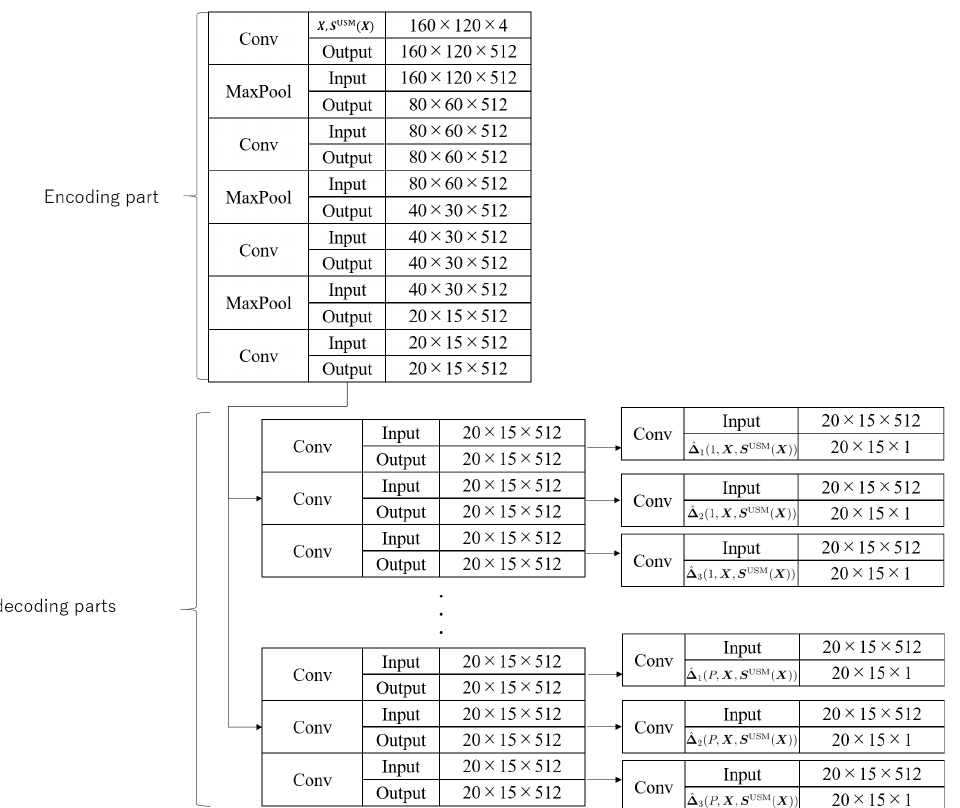
Figure 3. The details of the multi-task CNN used in our method. In this figure, “Conv” and “MaxPool” mean applying a convolution and maxpooling layer to each input data,